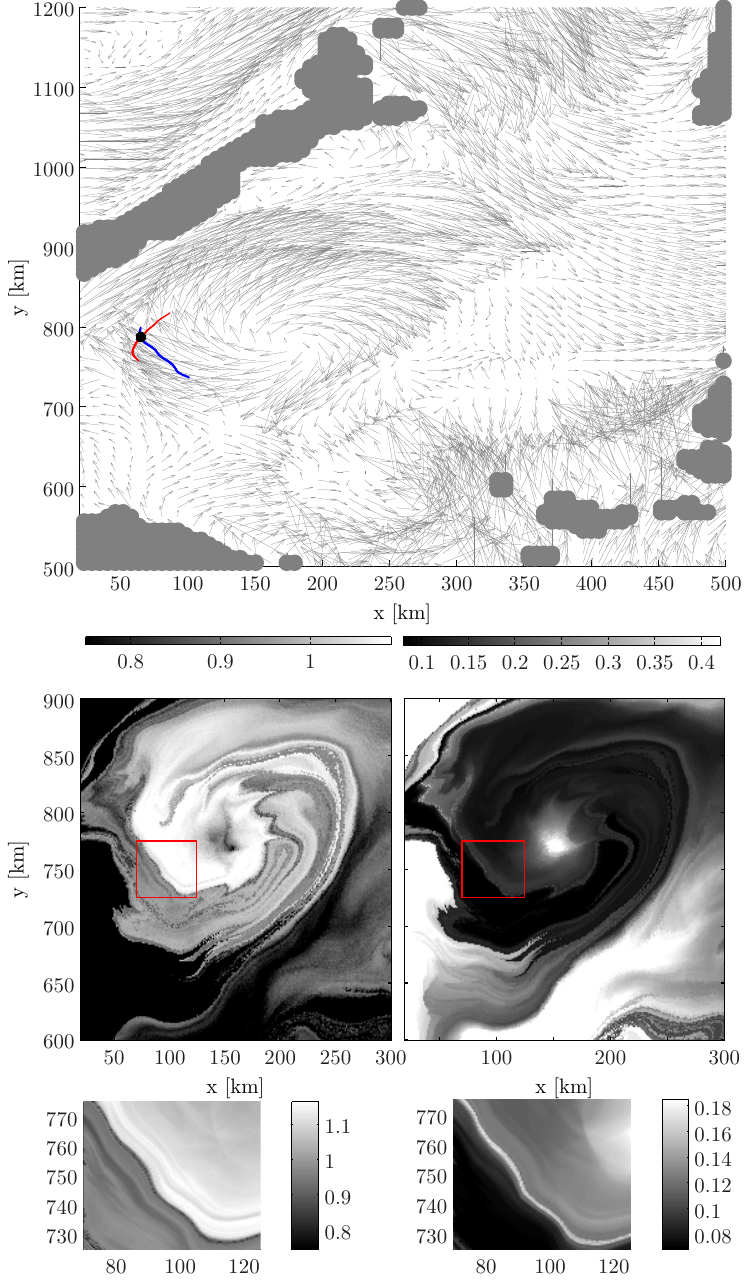
Fig. 4. (top) velocity and manifolds; (lower left) c and (lower right) d mean fields for the numerically-generated flow field produced by ROMS on 15 June